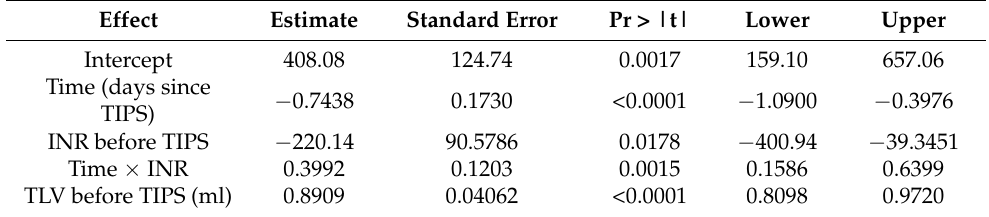
Table 7. Regression coefficients for the final multivariate model for the development of total liver volume.